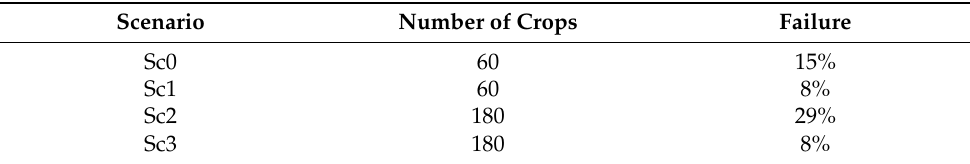
Table 3. Percentage of crop failure over the 15-year climatic serie. Scenario Number of Crops